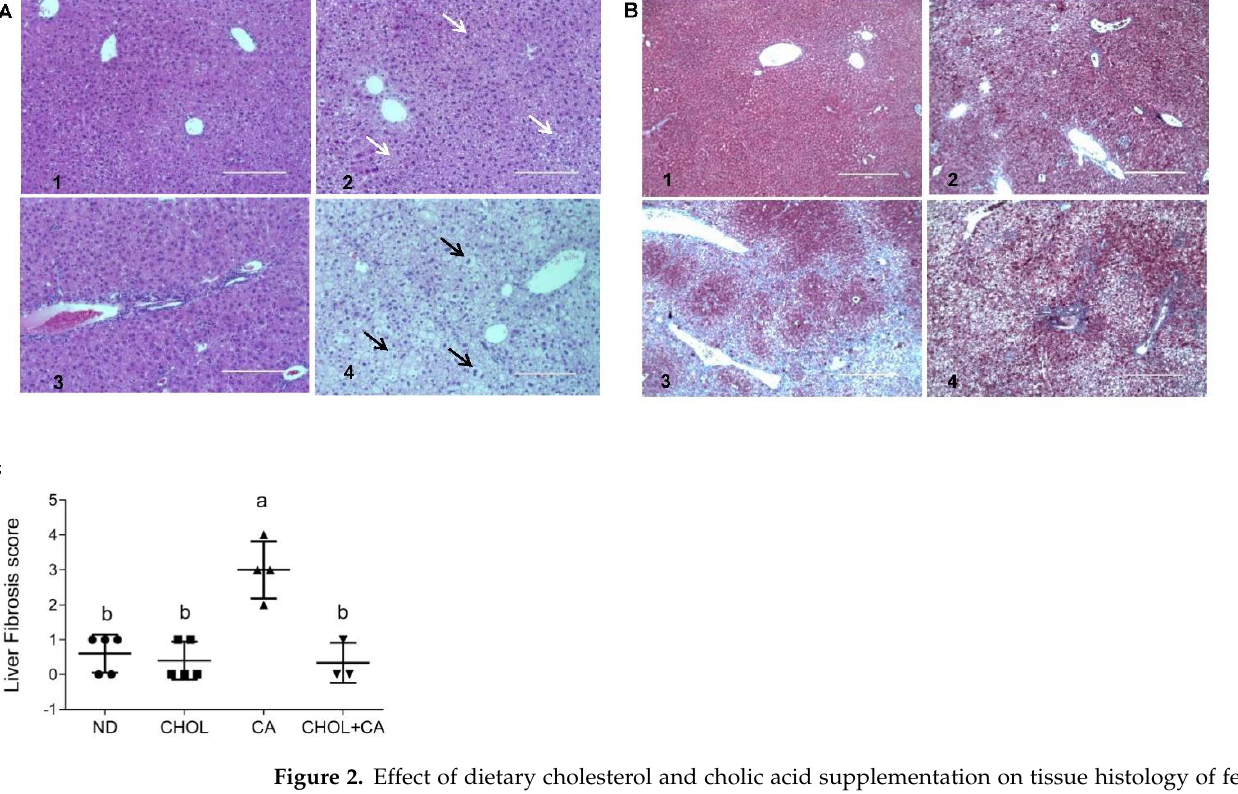
Figure 2. Effect of dietary cholesterol and cholic acid supplementation on tissue histology of features of fibrogenesis. Male C57BL/6J mice aged four to five weeks were fed: ND — normal diet, CHOL — cholesterol diet, CA — cholic acid diet, CHOL + CA — cholesterol and cholic acid diet for six weeks, with five animals in each treated group. ( A ) Representative liver H&E staining under ×20 magnification, scale bar 200 μm , for ( A1 ) ND group; ( A2 ) CHOL group (presence of microvascular fat accumulation marked with white arrows); ( A3 ) CA group (presence of necrotic cells with malformed nuclei); ( A4 ) CHOL + CA group (presence of ballooning degeneration of hepatocytes, accumulation of lipid droplets and Mallory-Denk bodies). Hepatocyte ballooning marked with black arrows. ( B ) Representative liver Masson’s trichrome staining under × 40 magnification, scale bar 400 μm , for ( B1 ) ND group; ( B2 ) CHOL group (few visible collagen lesions); ( B3 ) CA group (high presence of fibrotic collagen lesions colored blue); ( B4 ) CHOL + CA group (few visible collagen lesions). ( C ) Liver fibrosis score. Columns indicated with different letters (a, b) are significantly different ( p < 0.05) in Tukey-Kramer post-hoc test.